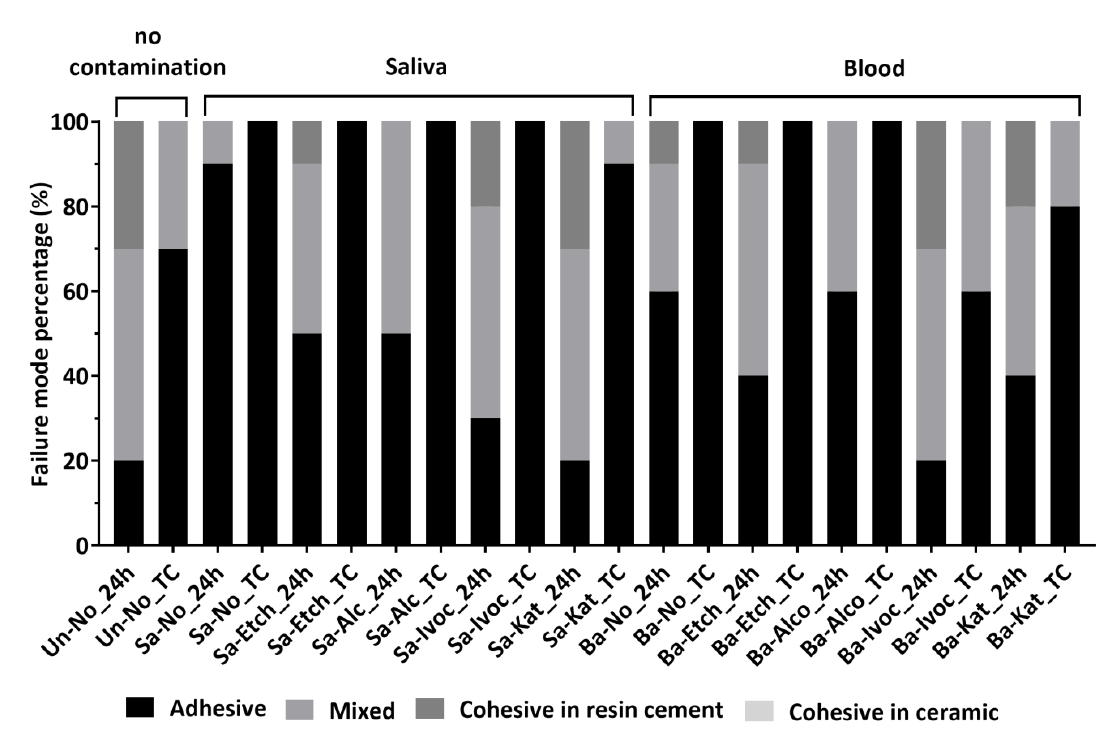
Figure 4. The frequencies of failure modes (expressed as percentages) recorded for all shear bond strength tested groups (Un: uncontaminated; No: water rinsing (no cleaner); Sa: saliva; Etch: phosphoric acid etching; Alc: 70% isopropanol alcohol; Ivoc: Ivoclean (Ivoclar Vivadent); Katana Cleaner (Kuraray Noritake) at 24 h and after thermocycling (10 k TC). The incidence of adhesive and mixed failures was the most common in saliva- and blood-contaminated groups.